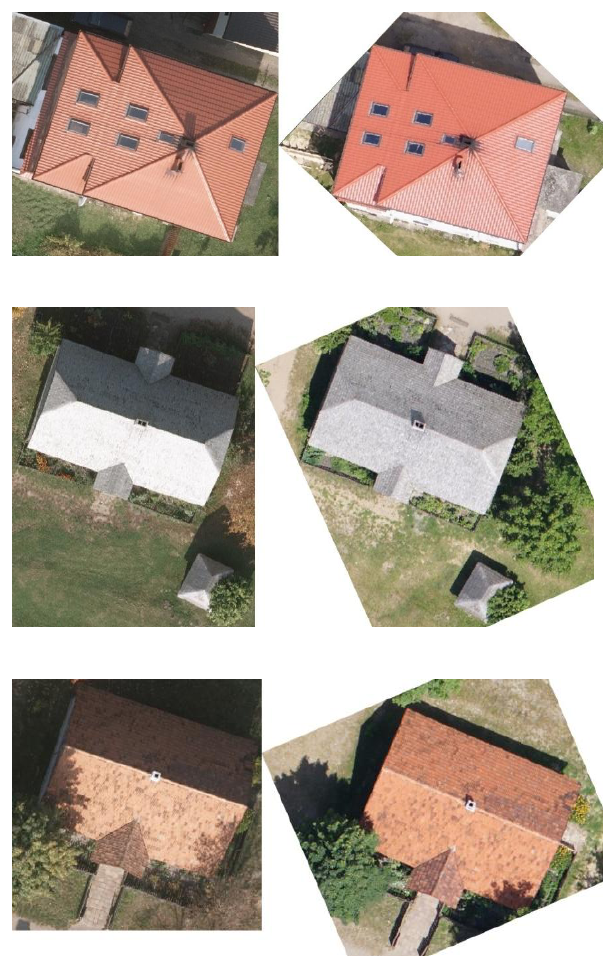
Figure 8. Comparison of images taken from the aircraft - classic (left) and UAV (right) for the same area – a selected building. Images from UAV have been rotated to obtain a similar position of the building.